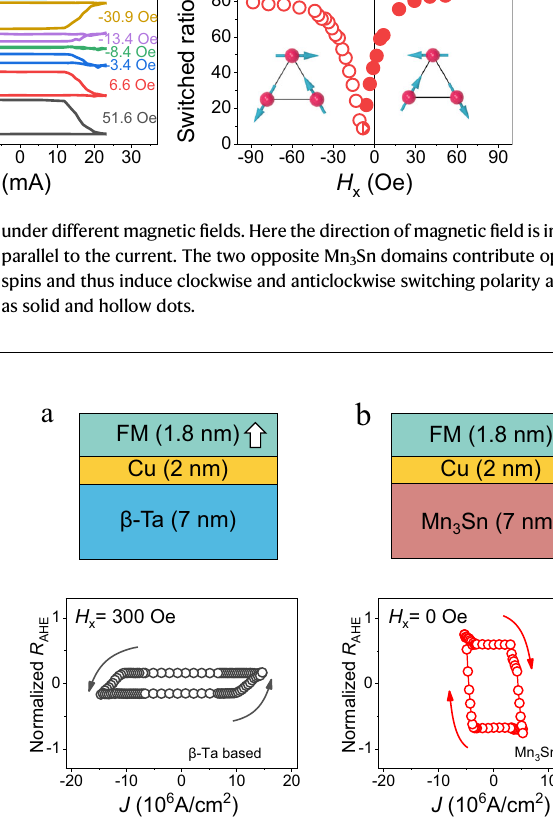
Fig. 4 | High MSHE based SOT ef fi ciency with the assistance of z spin polar- ization. a The conventional SHE based SOT device with a structure of β -Ta (7)/Cu (2)/FM(1.8)anditsmaximumcurrentinducedmagnetizationswitchingcurveatthe external magnetic fi eld of 300 Oe. b . The novel MSHE based SOT device with a structure of Mn 3 Sn (7)/Cu (2)/FM (1.8) and its current induced magnetization switching curve of Mn 3 Sn based device with the absent of external magnetic fi